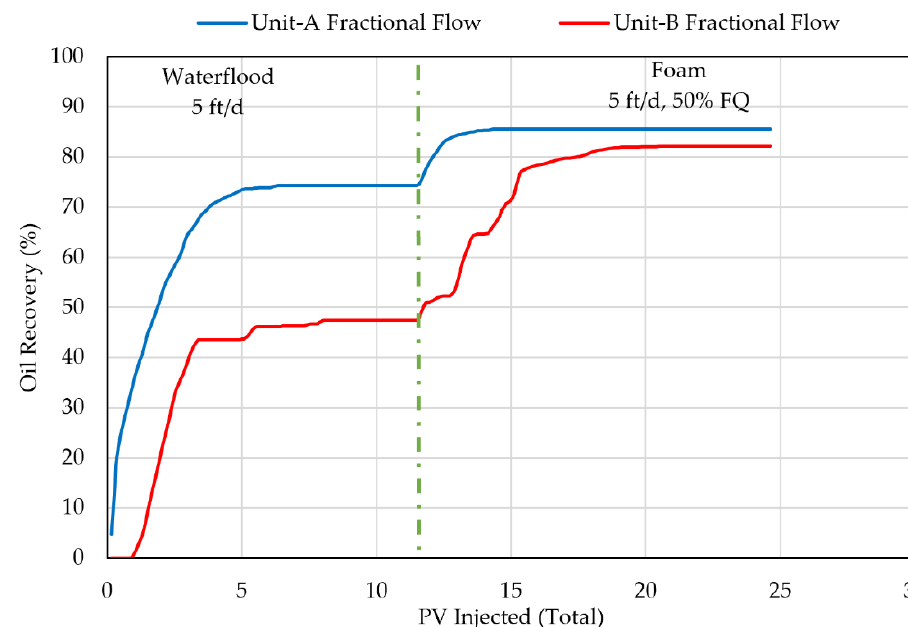
Figure 13. Oil recovery (%) from Unit-A and Unit-B cores for DI-Exp